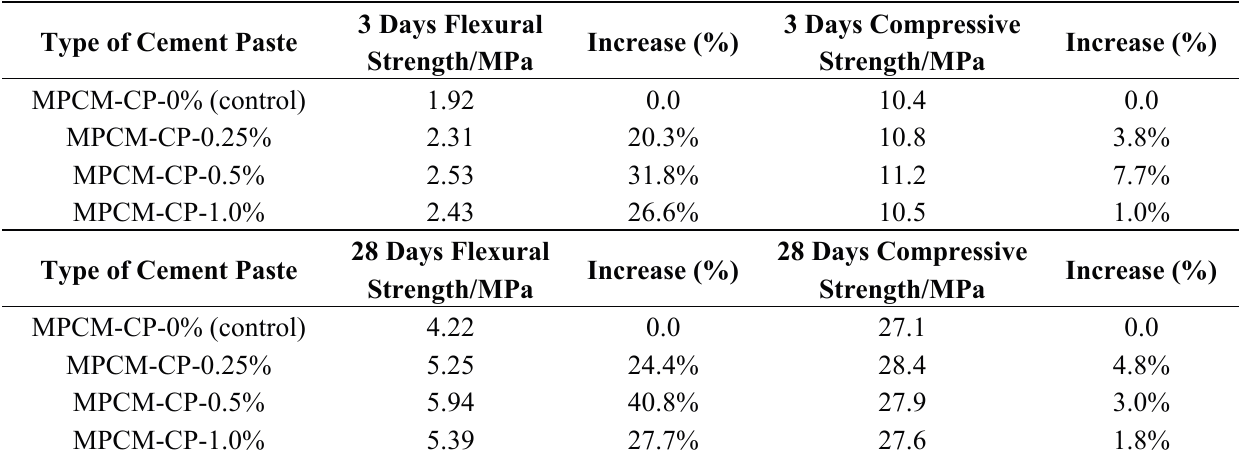
Table 1. Mechanical properties of CNTs modified